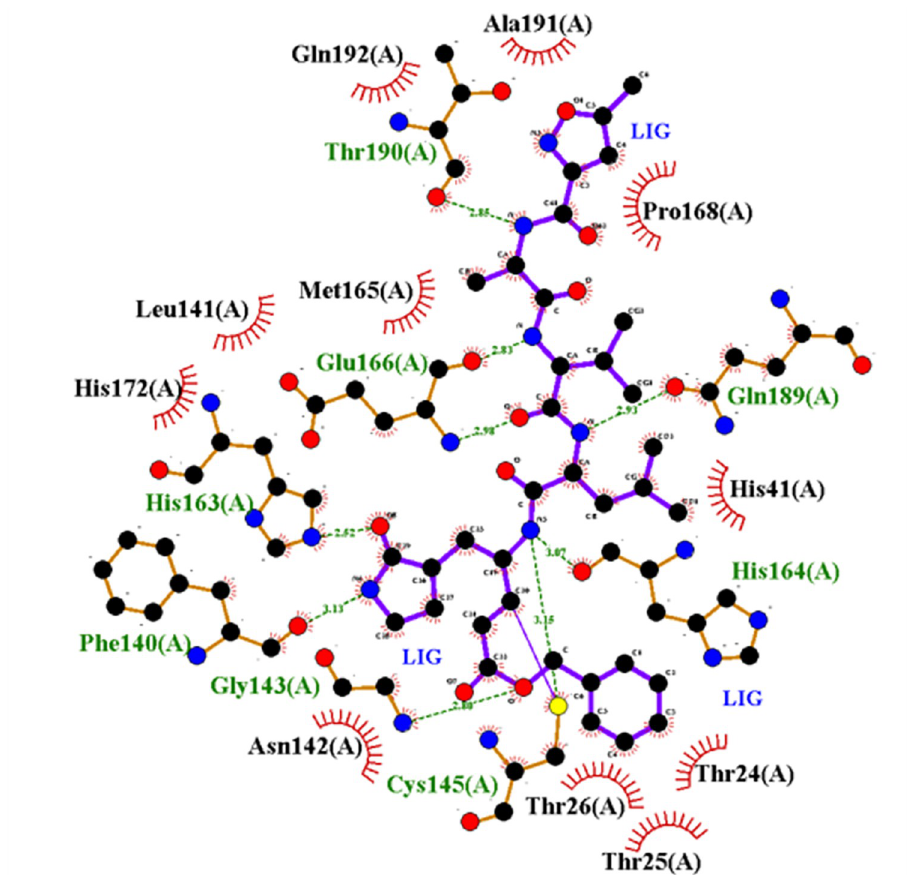
Fig 4. Interaction plot of native inhibitor N3 with 3CL protease in the protein crystal structure 6LU7. Hydrogen bonds are shown in the green dashed line. Other residues formed hydrophobic contacts.